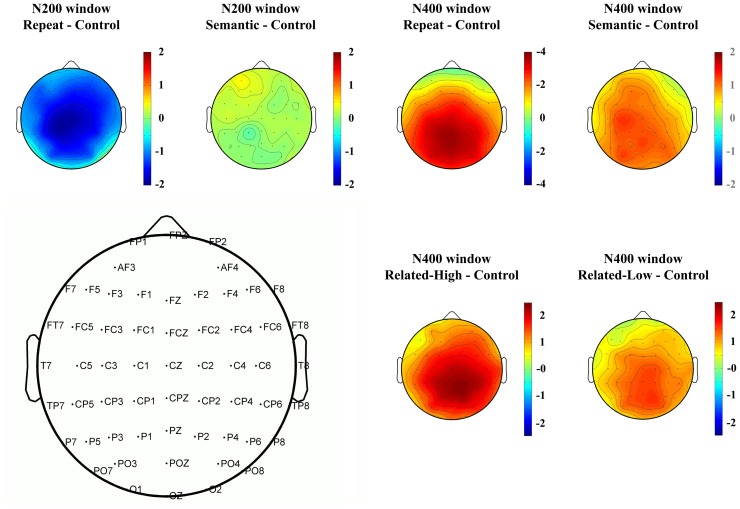
Scalp distribution for difference waves.The upper panel shows topographical distribution in N200 and N400 time windows for Exp. 1, and the lower panel shows topographical distribution in N400 time window for Exp. 2. The N200 time window results are not plotted for Exp. 2 due to absence of effects. Note scale differences in different maps.